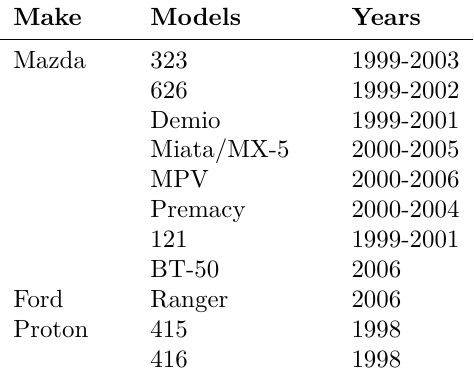
Table 1: Vehicles with TK5561